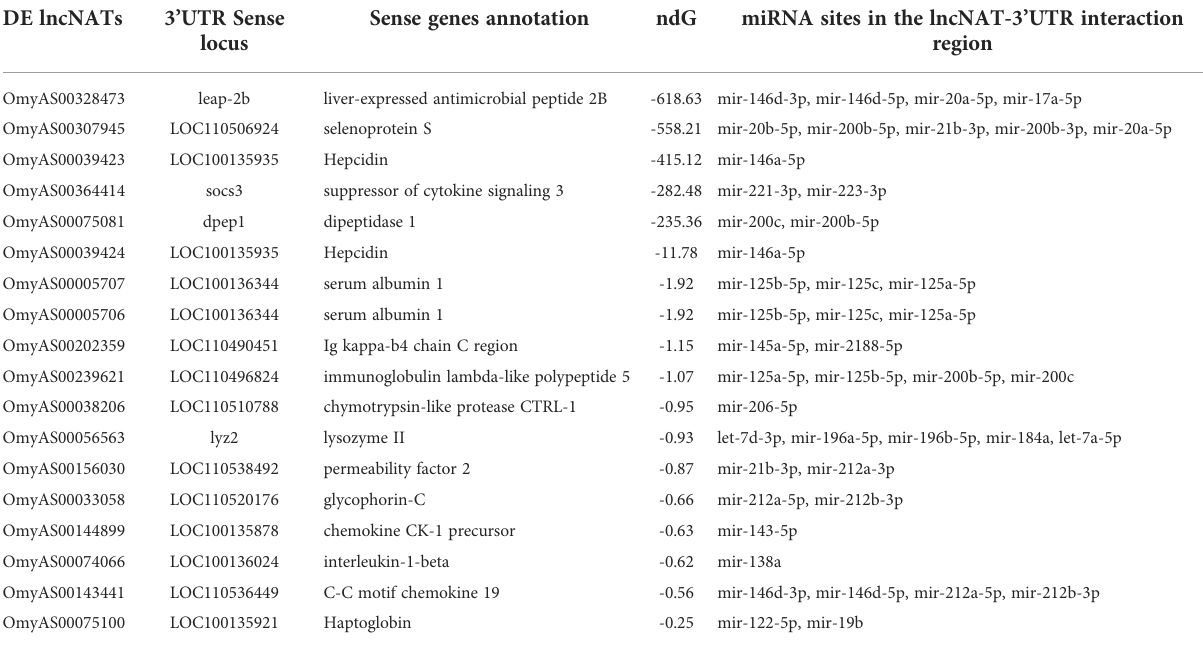
TABLE 4 DE lncNATs interacting with the 3 ’ UTR of cognate genes and masking microRNA target sites. ndG is the normalized binding free energy. DE lncNATs 3 ’ UTR Sense Sense genes annotation ndG miRNA sites in the lncNAT-3 ’ UTR interaction locus